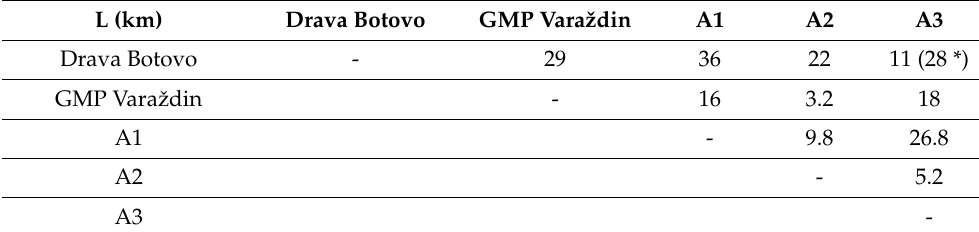
Table 1. Aerial distances between individual locations.